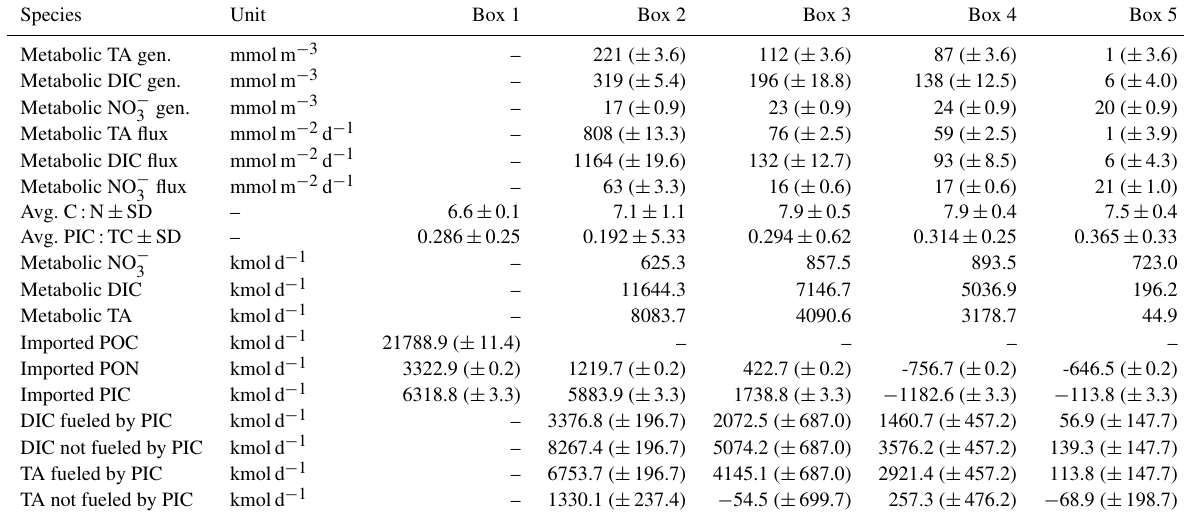
Table 3. Mass balance results and POM properties. The mass balance results are shown as metabolic generation (i.e., gains) in concentrations (mmolm − 3 ) , in fluxes of total alkalinity (TA), dissolved inorganic carbon (DIC), and nitrate (NO − ), respectively (metabolic fluxes are also 3 visualized in Fig. 5), and in kilomoles per day (kmold − 1 ). The average carbon:nitrogen (C:N) and particulate inorganic carbon:total carbon (PIC:TC) ratios of suspended particulate matter (SPM) are given per box. The observed imported POC and particulate organic nitrogen (PON) values based on sampled filters in box 1, as well as the calculated transported values for PON in the other boxes (2–5) (Sect. 2.3), are shown. Imported PIC for box 1 was calculated based on imported POC, and transported PIC values were calculated for the other boxes (2–5) (Sect. 2.3). DIC fueled by PIC and TA fueled by PIC give the amount of each that can be fueled by imported and transported PIC. DIC not fueled by PIC and TA not fueled by PIC give the amount of each that is remaining and not fueled by imported PIC, i.e., CaCO 3 dissolution. The standard deviation ± SD as spatial variability is given when possible. An uncertainty estimation for analytical measurements, the air–sea flux estimation, and the river discharge is given as ( ± absolute errors) by an error propagation (Sect. 2.3). Imported POC, PIC, and PON to the estuary were estimated using measured average POC (596 ± 52µmolL − 1 ) and PON (91 ± 8µmolL − 1 ) concentrations of